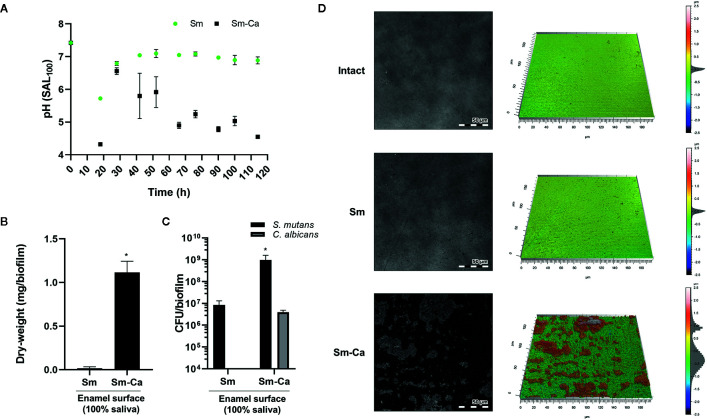
Demineralization of human enamel surface by Sm and Sm-Ca biofilm in SAL100. (A) pH changes in Sm and Sm-Ca biofilm throughout the biofilm experiment. (B) Biomass (Dry-weight) of biofilms and (C) CFU of S. mutans and C. albicans in Sm and Sm-Ca biofilms at final phases (114 h). (D) Representative confocal surface-topography and roughness of enamel surfaces (Scale bar: 50 µm). Asterisk indicates that the p-values are significantly different from Sm biofilm (Student’s t-test; *P < 0.05).